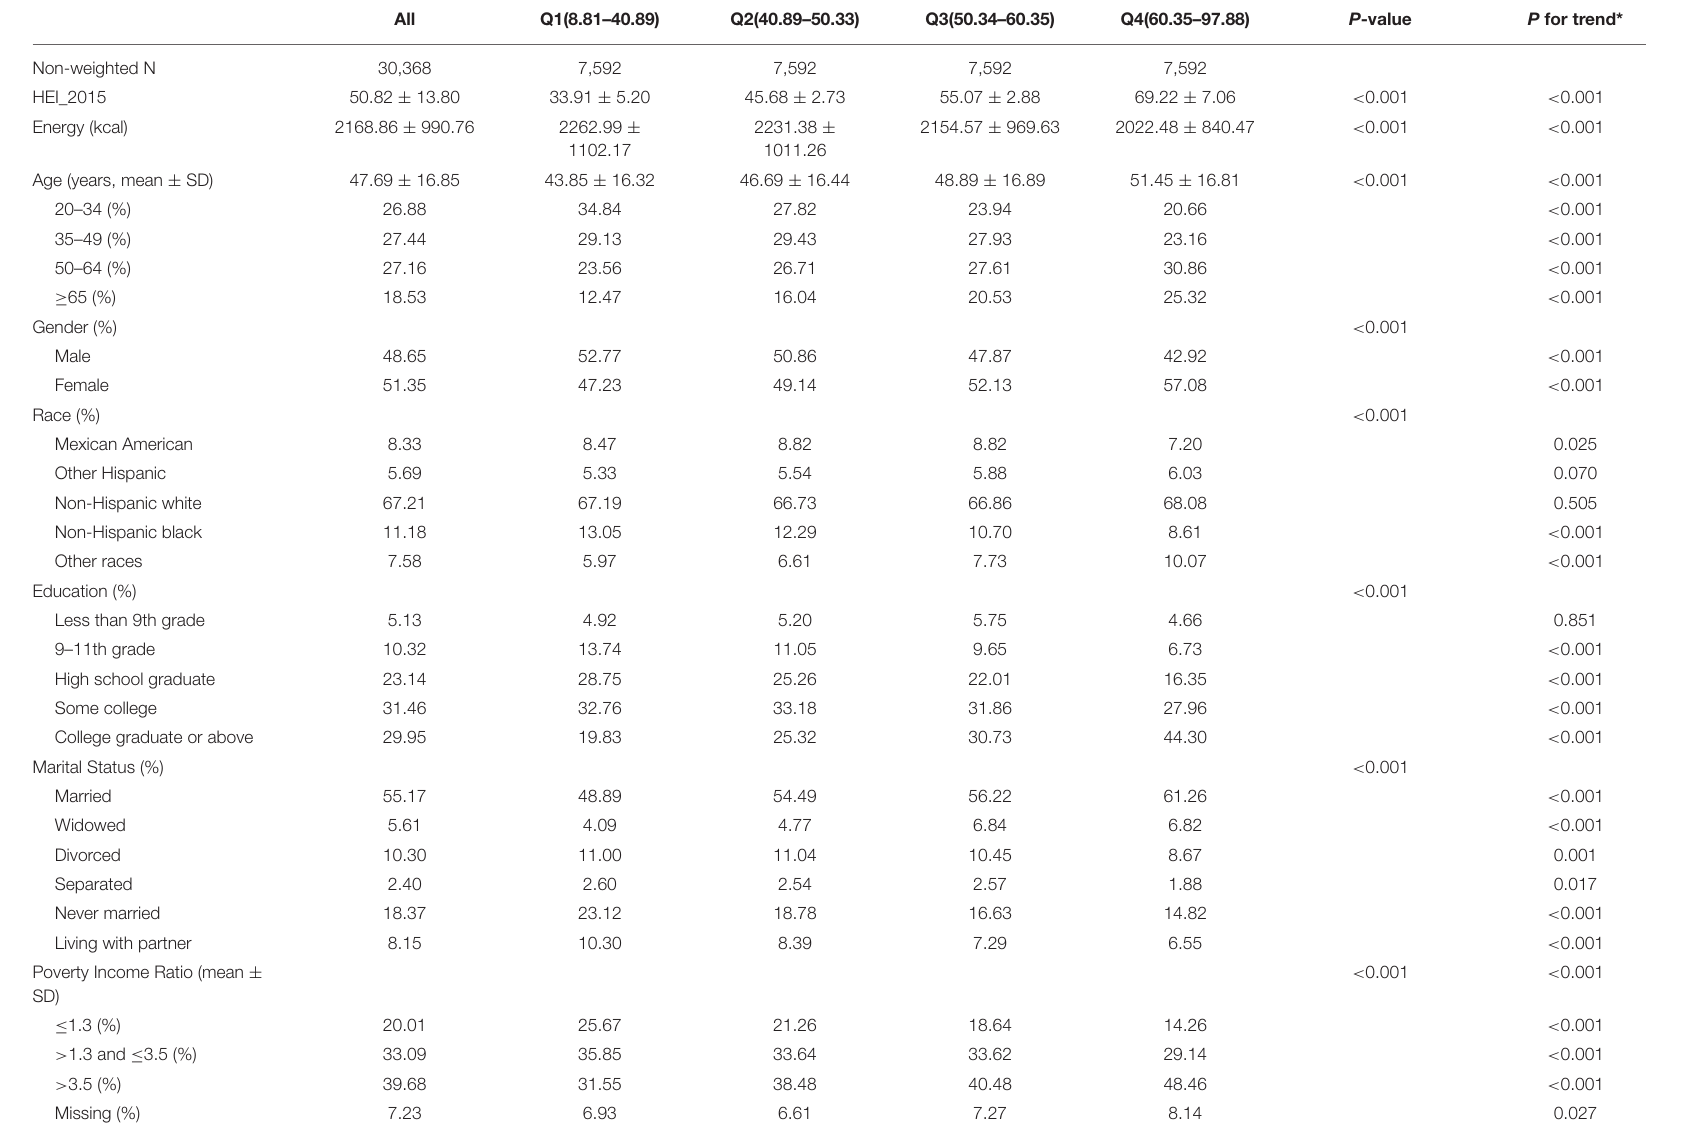
TABLE 1 | Characteristics of participants by categories of Healthy Eating Index 2015: NHANES